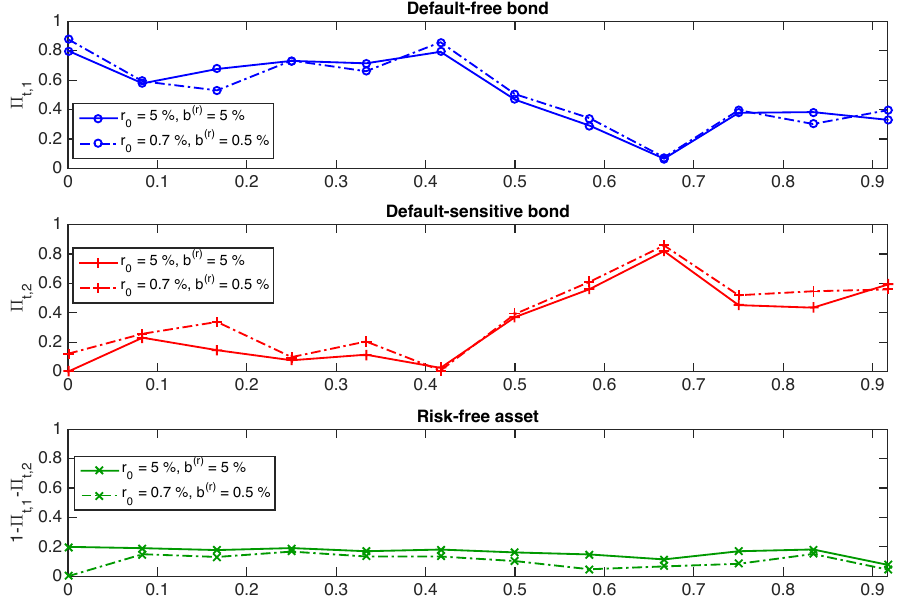
Figure 4. Sensitivity of optimal strategies to a change in the level of short